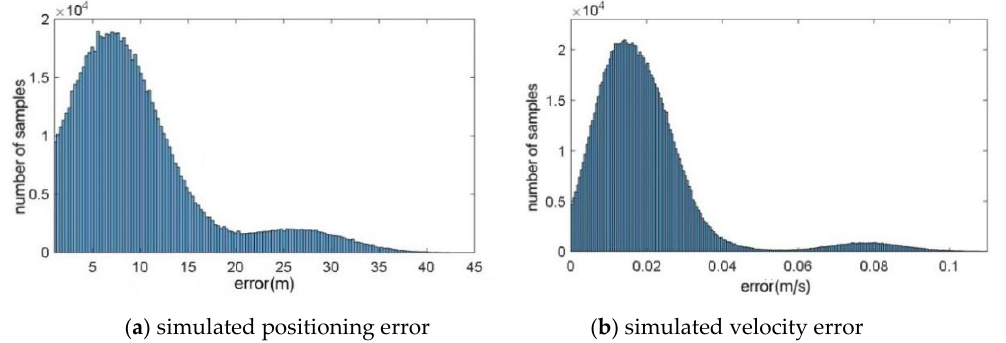
Figure 11. Second layer CPN model of scenario in detail.